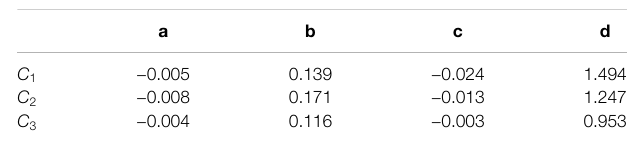
TABLE 5 | Coef fi cients to Eq. 5